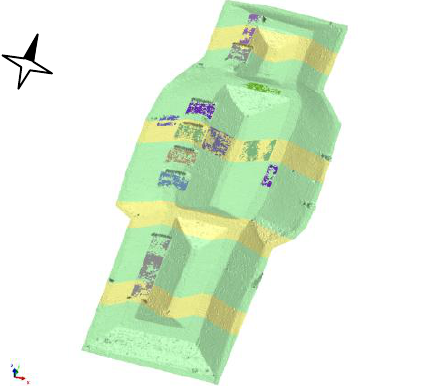
Figure 4. Selected patches and segments 1 to 4 (yellow band, numbered from south to north) used for accuracy comparisons At these segments the deviations of UAS surface against the TLS surface were compared (Table 2) and visualized. In the Figure 3. Overall model with surface differences (view from compared segment 1 with 42543 points (Figure 5), the standard south east). Areas with constructional reworks (ellipses), deviation of the surface differences is in the range of 0,022 m areas with geo-textiles (polygones) and with an average error of 0,010 m (max. deviation: 0,274 m, min. areas with greater vegetation growth (broken green line). deviation: -0,124 m).